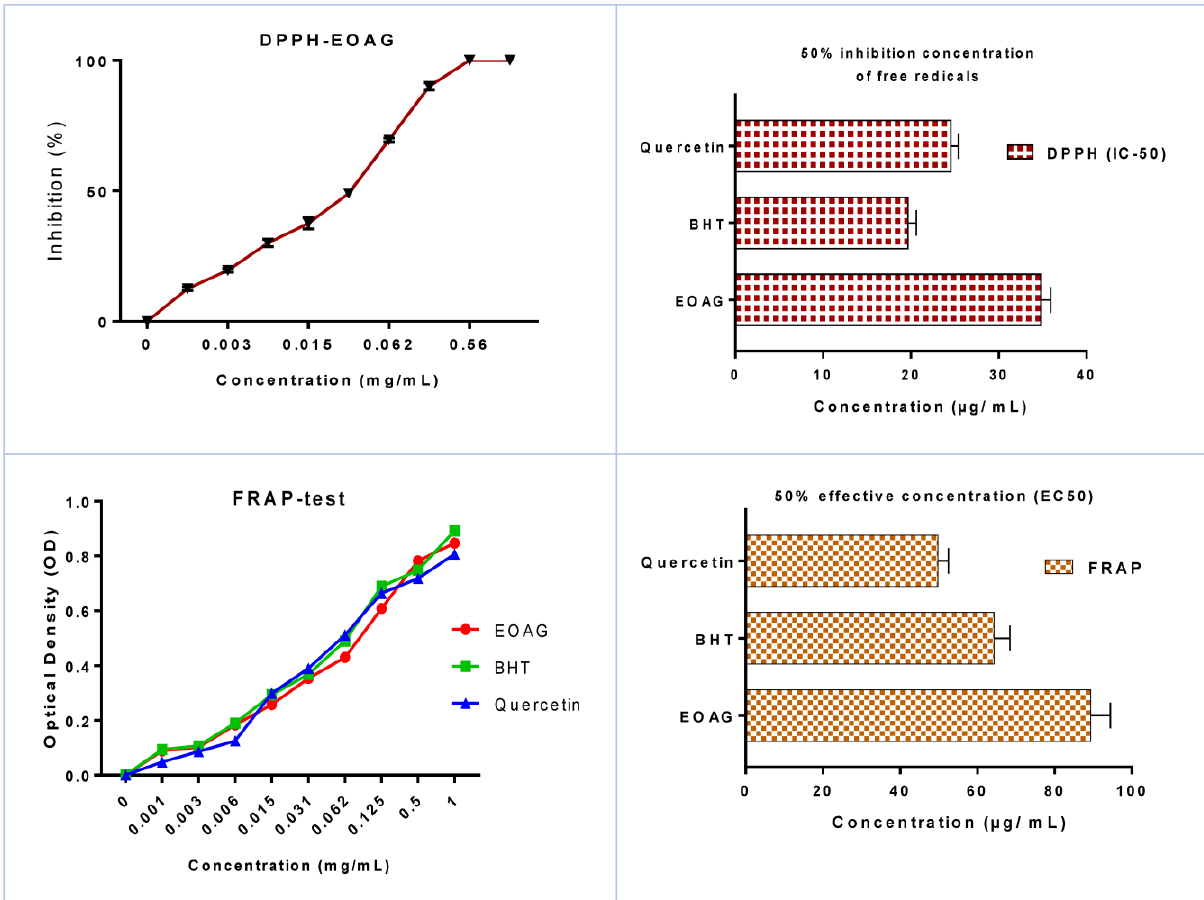
Figure 3. The antioxidant power of EOAG by the FRAP (EC 50 ) and by DPPH (IC 50 ) assays.